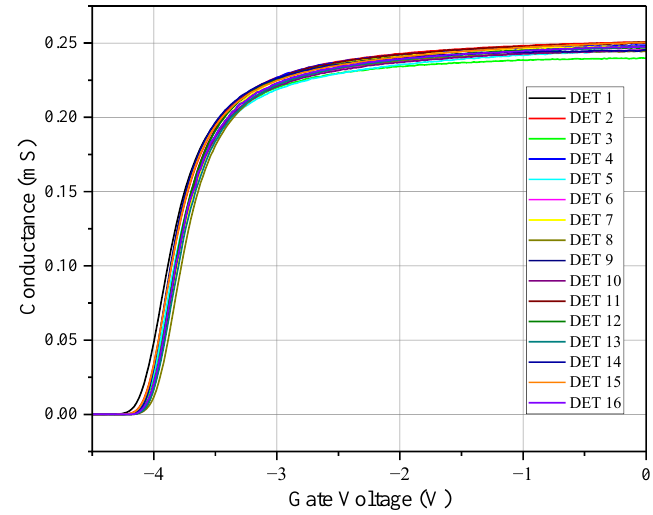
Figure 5. The conductance of the 16 pixels of the TeraLDA. Table 1. Comparison of the theoretical noise and the measured